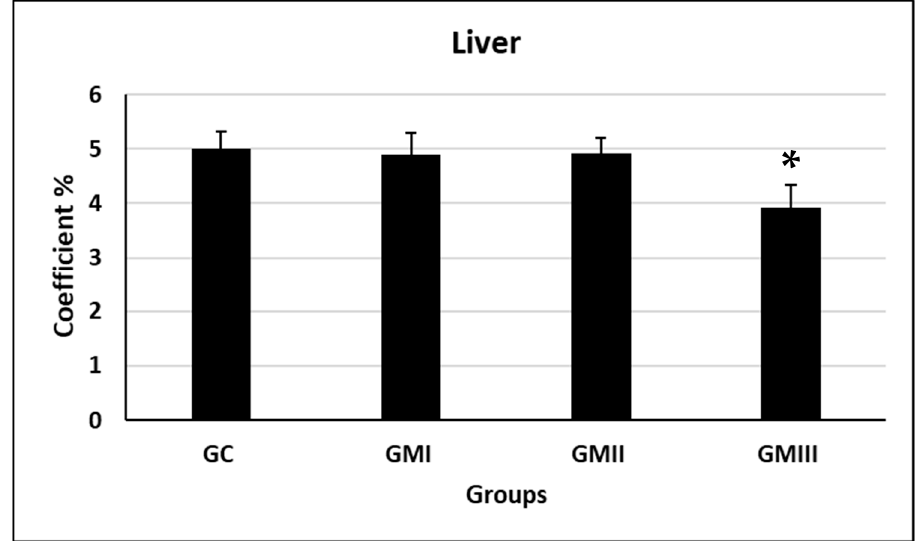
Figure 1. Liver coe ffi cient of pregnant rats ( n = 10.) * Signi fi cant di ff erences with respect to the con- trol group (GC) p ≤ 0.05. group (GC) p ≤